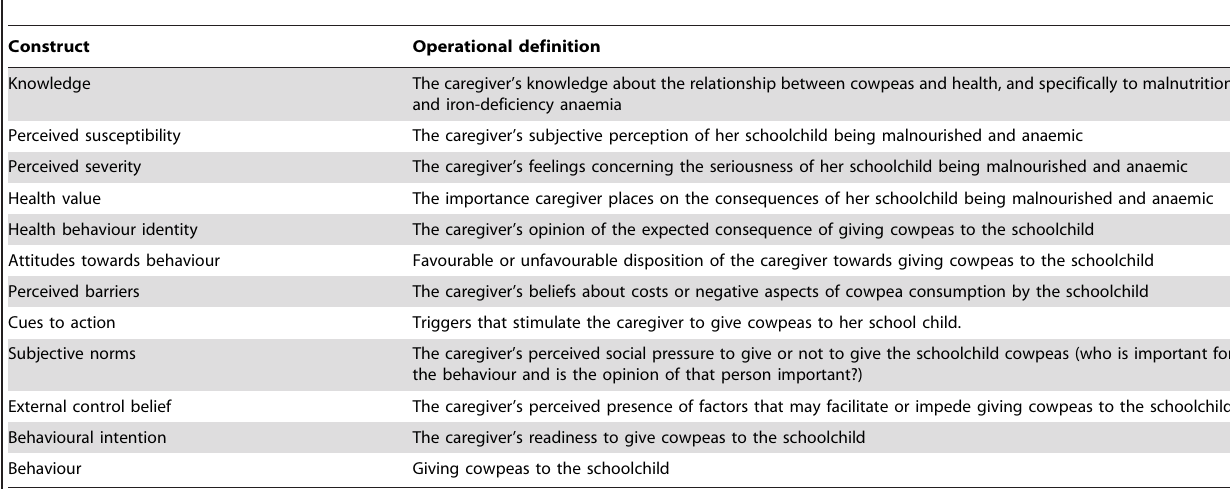
Table 1. Operational definition of constructs used to examine factors that predict intention of caregivers to give cowpeas to their schoolchildren.